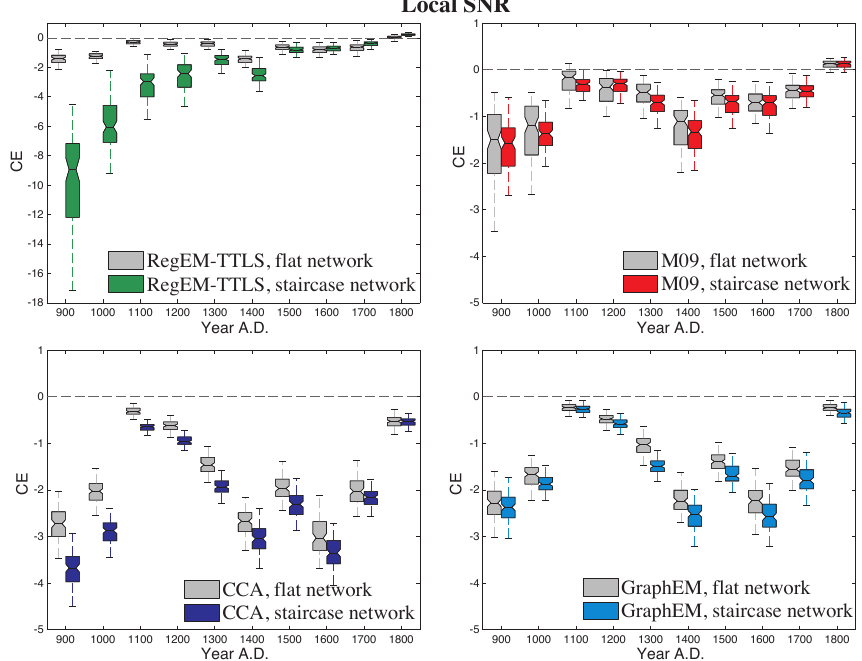
Fig. 7. Temporal variation of globally averaged CE, within CFRs derived from the local SNR network. Spatial CE is first calculated for each grid box, and then global averages are calculated using area-weighted means. Each box plot represents CE scores from the 100-member ensemble for each 100yr slice between 850 and 1850AD. For example, the box plot with time slice 900 corresponds to the global mean CE between 850- and 950AD. Note that the y scale for RegEM-TTLS is different from the other